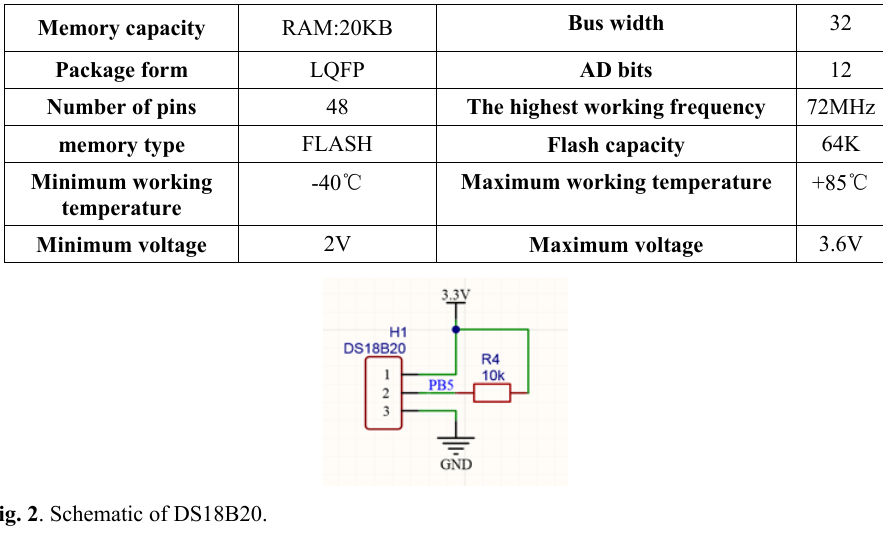
Fig. 2 . Schematic of